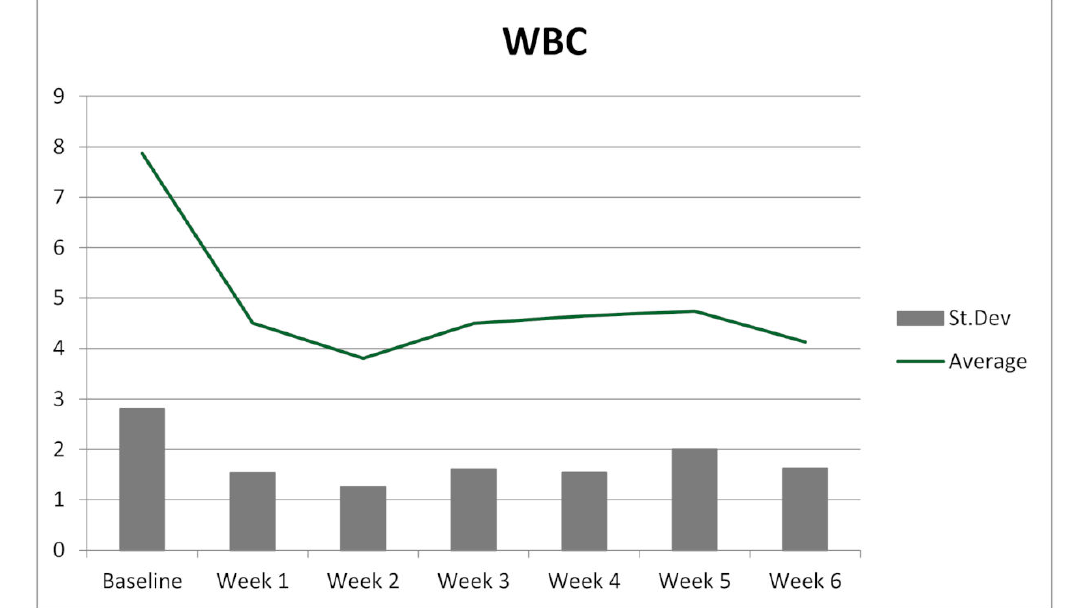
Figure A1. White blood cell count trend during treatment.